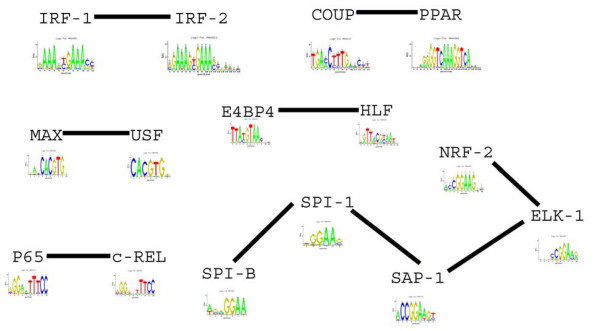
Transcription factors with significantly overlapping sequences in Humans. Edges connect two TFs with similar binding sequences. Sequence logos are shown for each TF.